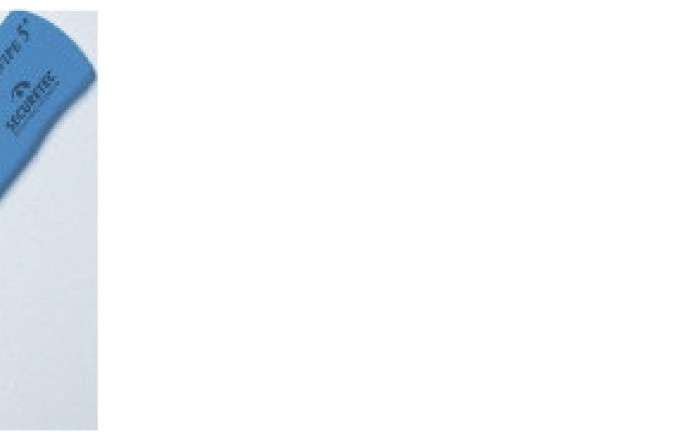
Figure 3. Saliva drug test Securetec DrugWipe device (reproduced with permission from Elsevier, Ref. [62]).